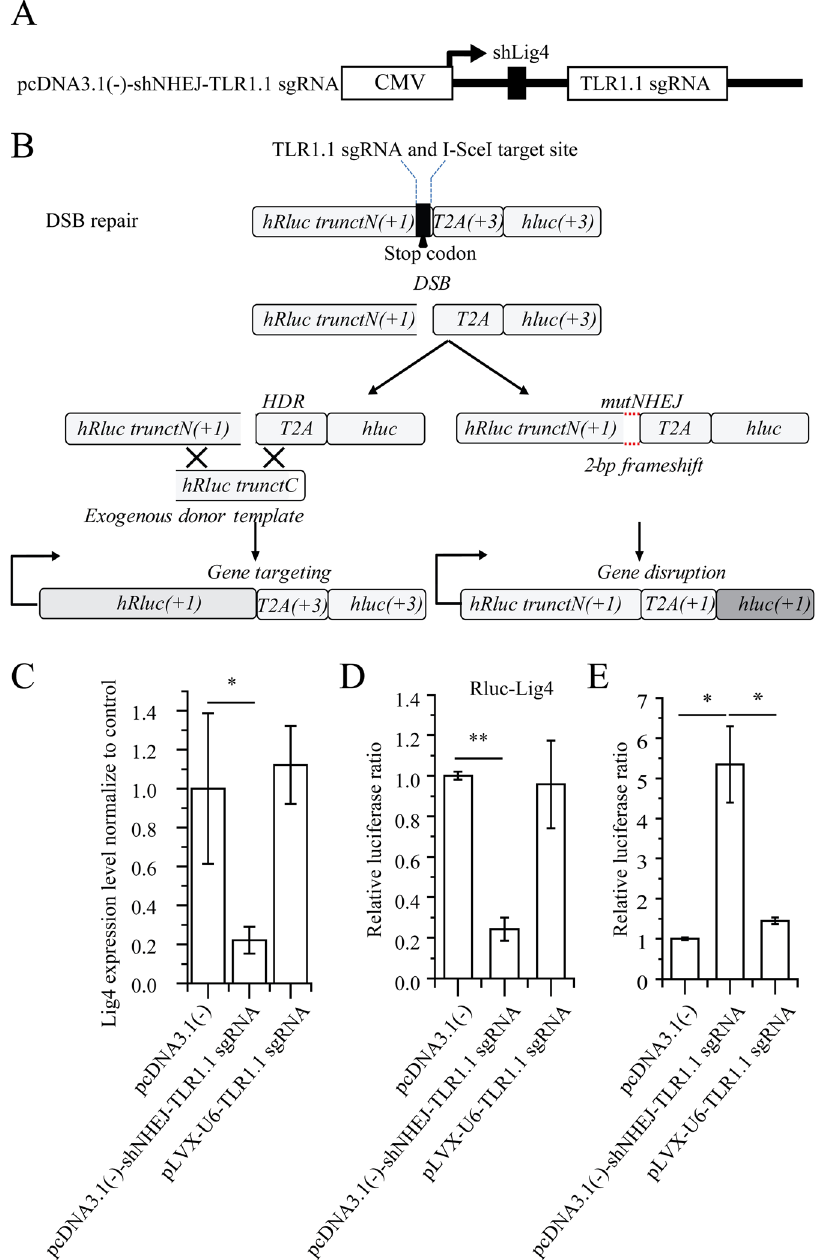
Figure 5. MiRNA based sgRNA cassettes can be modified to alter the proportion of HR in genome editing. ( A ) Schematic overview of pcDNA3.1( − ) shNHEJ-TLR1.1 sgRNA construction. ( B ) Schematic overview of the principle of detection of the ratio of HR and NHEJ. qRT-PCR ( C ) and luciferase reporter assay ( D ) were used to demonstrate that Lig4 was effectively suppressed by pcDNA3.1( − ) shNHEJ TLR1.1 sgRNA. ( E ) Gene editing with pcDNA3.1 ( − ) shNHEJ TLR1.1 sgRNA had a higher efficiency of homologous recombination compared to pLVX-u6-TLR1.1 sgRNA. pcDNA3.1( − ) shNHEJ TLR1.1 sgRNA or corresponding control was co-transfected into 293T with Cas9 expression plasmid, DSB repair reporter construction, and corresponding donor. Afterwards, luciferase assay was performed 3 days after